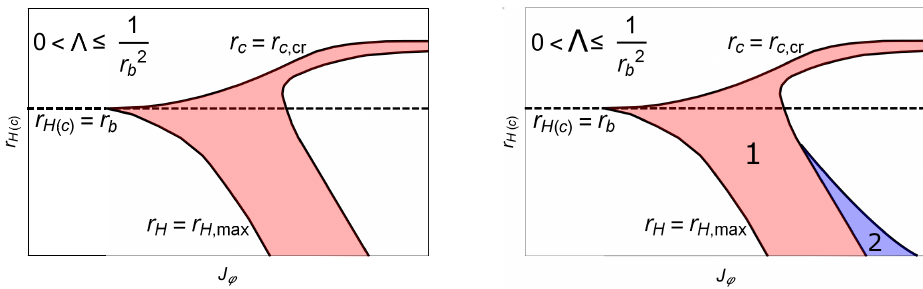
plane of Euclidean PL- Figure 15 . Examples of the structure of existence region on J ϕ − r H ( c ) soliton, PL-BH, and PL-BG instanton when 0 < Λ ≤ 1 . ( Left ) This type of structure appears r 2 b when Λ is sufficiently small compared to 1 /r 2 and M . This would be the simplest one. ( Right ) b When the condition no longer holds, the structure becomes complicated. The numbers in the figures represent the number of solutions with the same r and J . (Examples of parameters c ϕ √ √ that exhibit these structures are ( r Λ , M ) = (5 G, 0 . 012 /G, 0 . 5 / G ) ( Left ) and ( r b , Λ , M ) = b , √ √ (5 G, 0 . 036 /G, 0 . 5 / G ) ( Right ).)